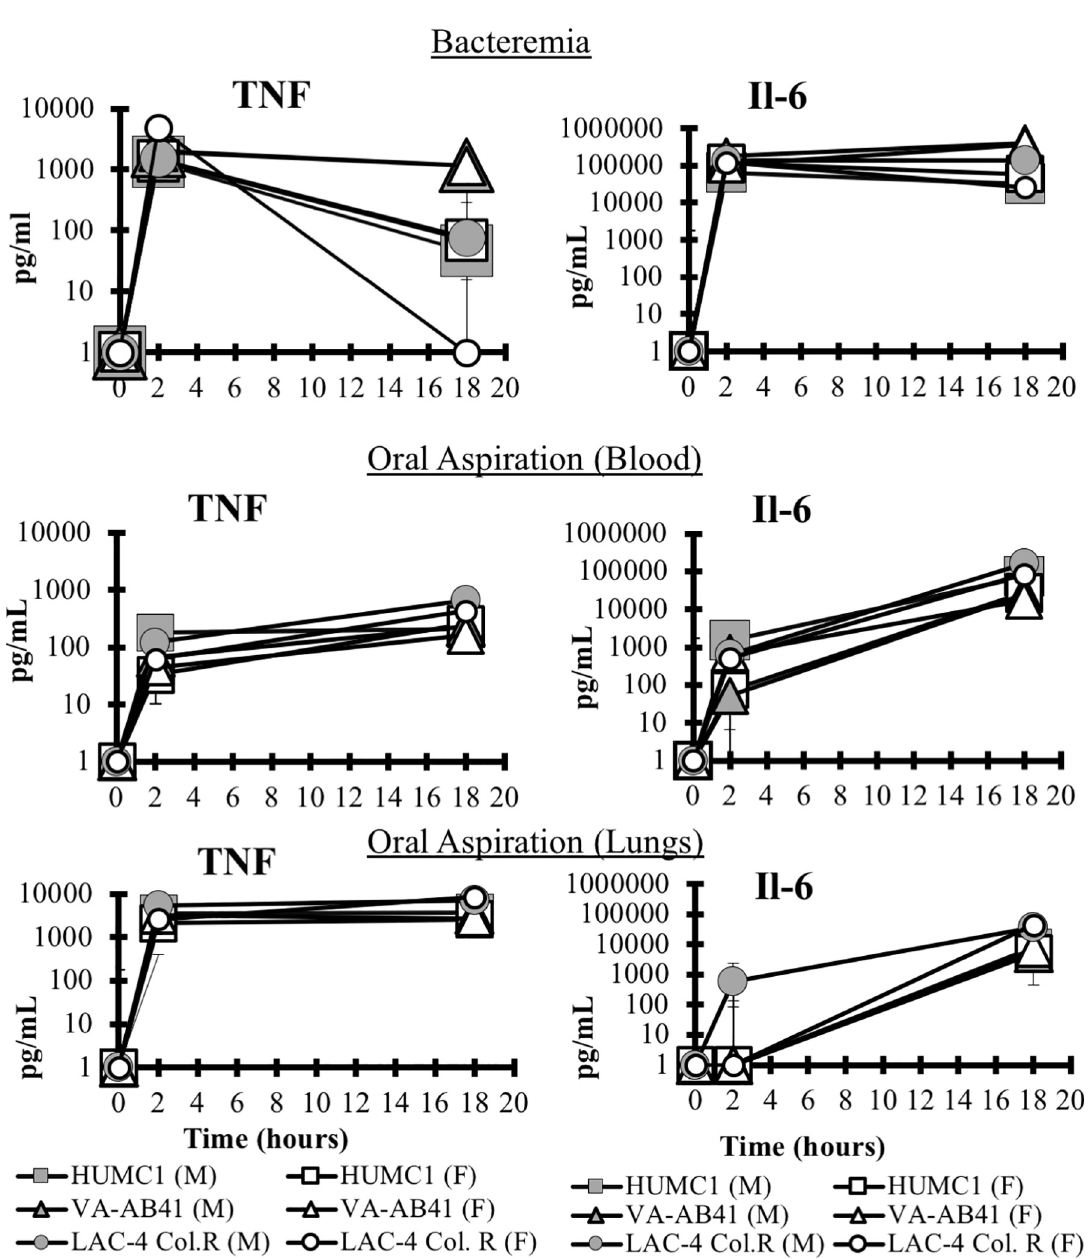
Fig 6. Host immune response. Blood samples were collected from healthy and infected mice at 2 and 18 hours post-infection. TNF was significantly upregulated at 2 hours and 18 hours for all infecting strains in both the bacteremia and OA infection models (P < 0.05) but only at 18 hours for IL-6 (P <